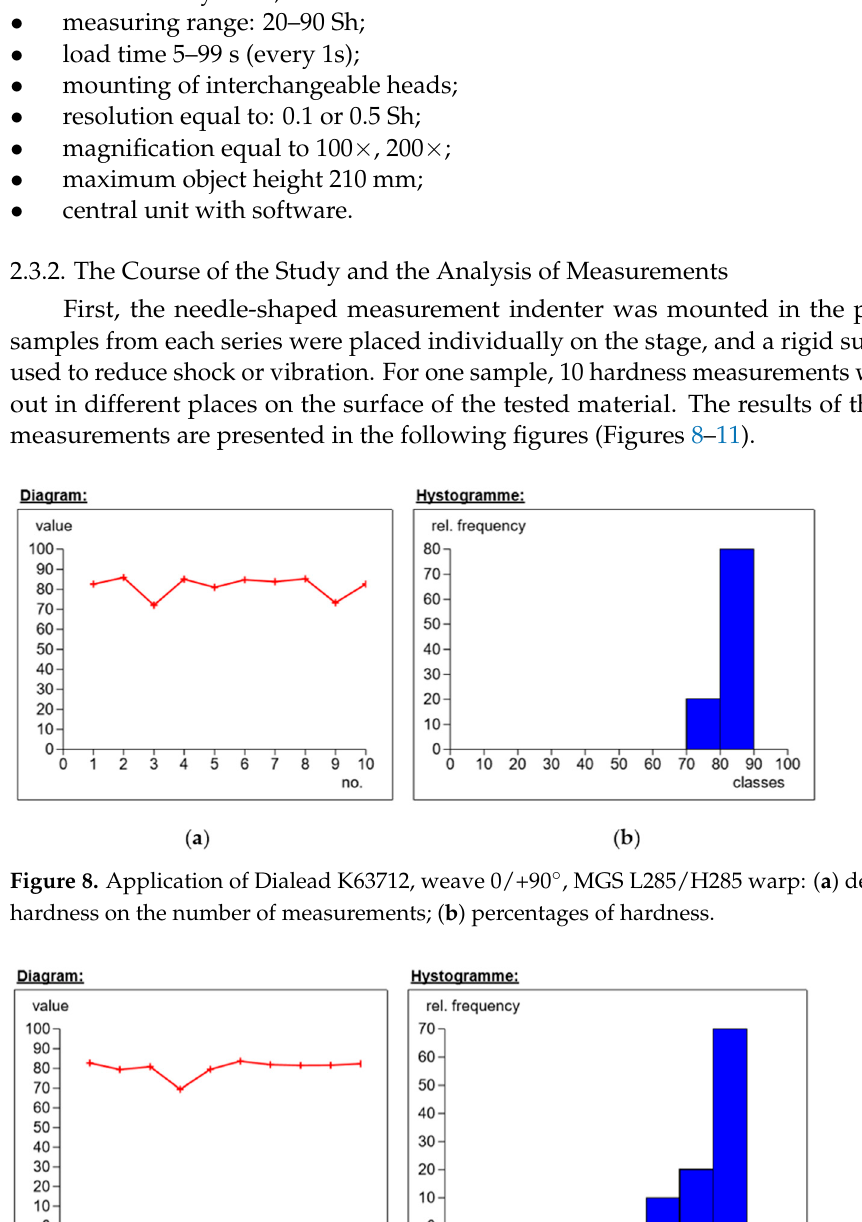
Figure 9. Use of Roving IMS65 fabric, weave 0/+ 90 ◦ , MGS L285/H285 warp: ( a ) dependence of hardness on the number of measurements; ( b ) percentages of hardness.